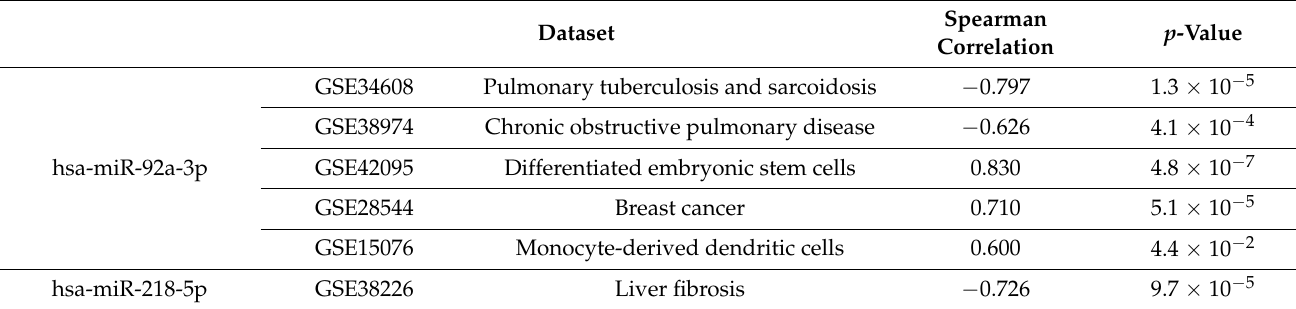
Table 3. Significant correlations between NAPRT and miRNA expression.